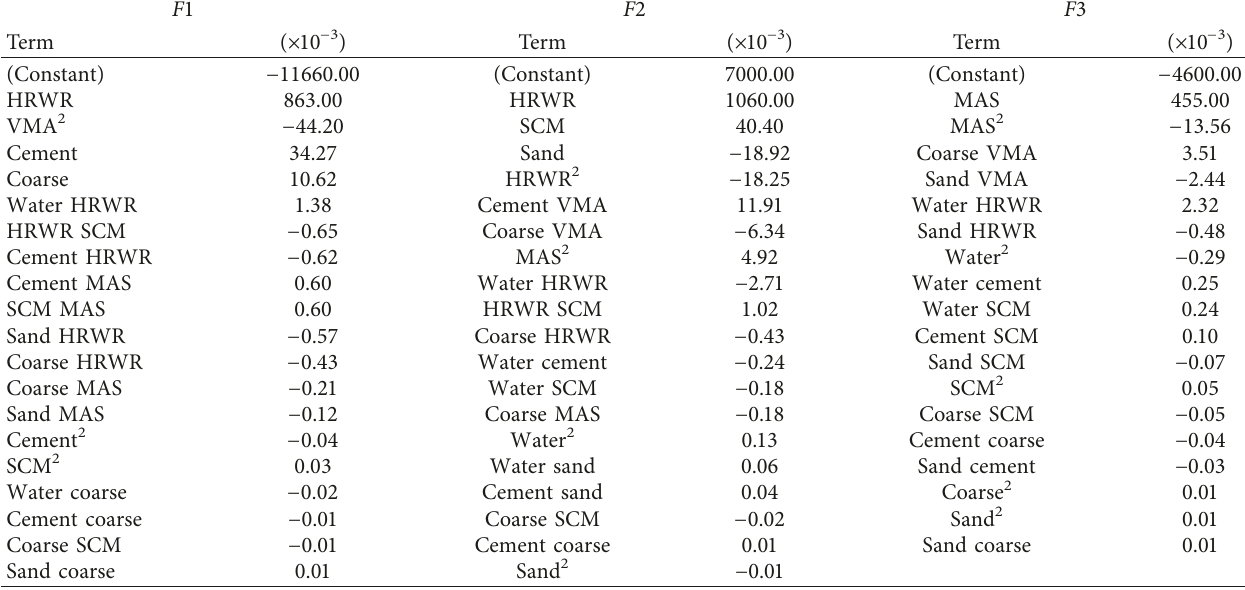
Table 5: Summary of the models developed: statistically significant terms and fitted coefficients. F 1 F 2